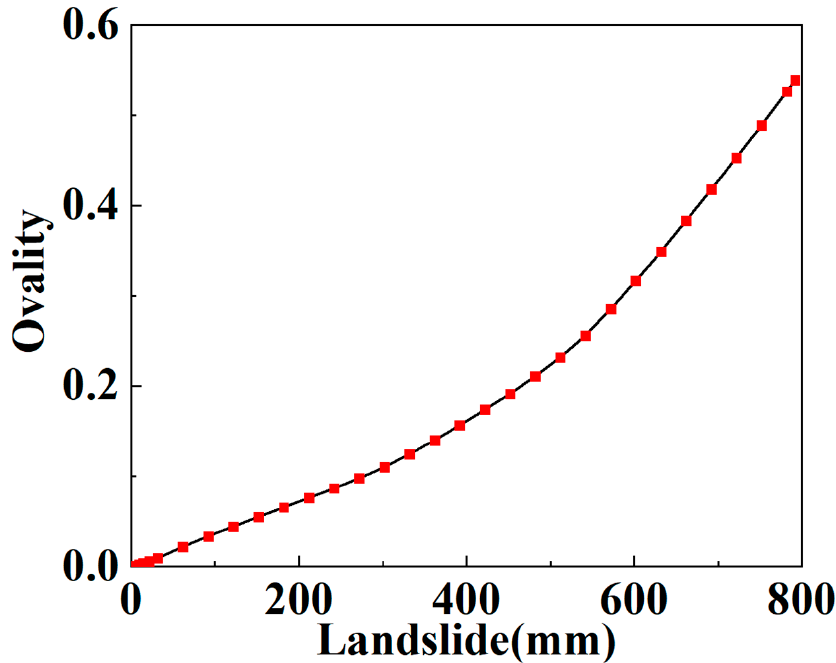
Figure 15. Variation in the maximum δ of the SWW-RTP with the landslide.